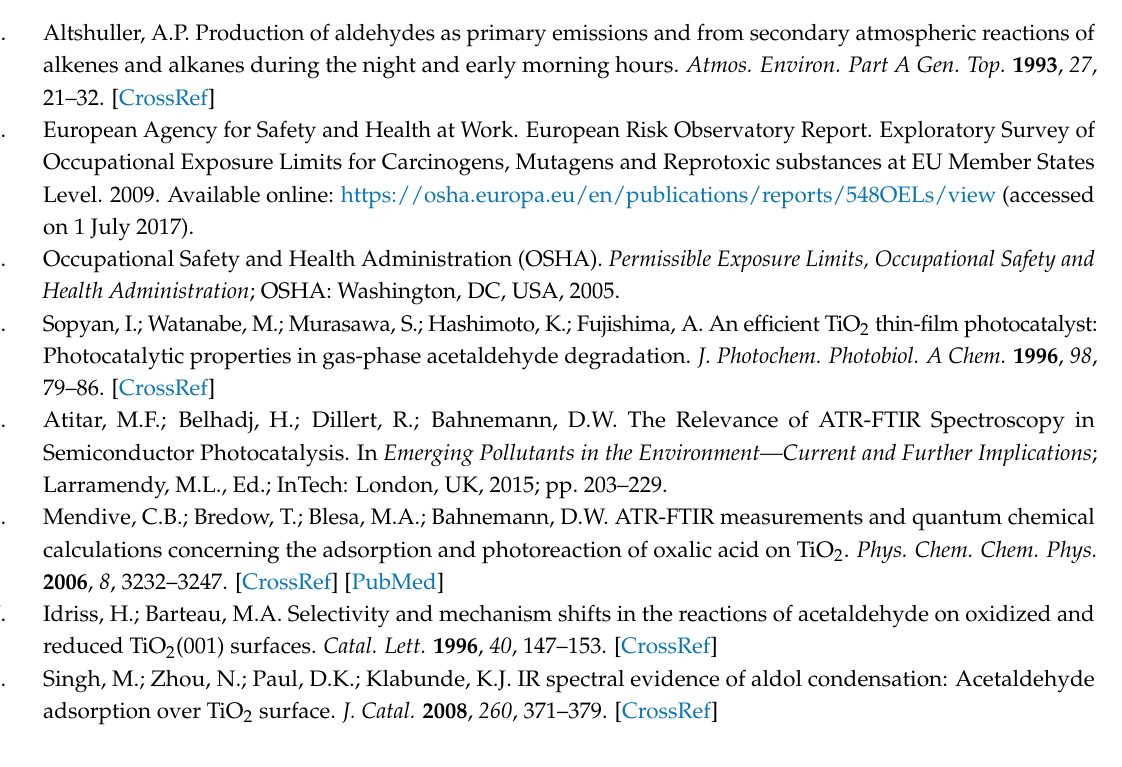
Figure S1: Acetaldehyde concentration as a function of time in the O 2 atmosphere in the dark. Figure S2: Time evolution of the QMS signal of the mass 41 m / z corresponding to crotonaldehyde. Figure S3: Comparison between the acetaldehyde concentration as a function of time in O 2 (left) and in N 2 (right) atmosphere in the dark. Figure S4: ATR-FTIR spectra recorded during gaseous treatment of acetaldehyde over an anatase film in O 2 (left) and N 2 (right) atmosphere for two hours in the dark. Figure S5: QMS signal as a function of the time of the masses 16 m / z and 44 m / z corresponding to CH 4 and CO 2 . Figure S6: XRD pattern of UV-100. Figure S7: Experimental setup for the ATR-FTIR measurement. Figure S8: Experimental set up to monitor the concentration of acetaldehyde as a function of time. Figure S9: Experimental set up for the detection of gaseous products generated during acetaldehyde treatment of a UV-100 film in the dark and upon UV